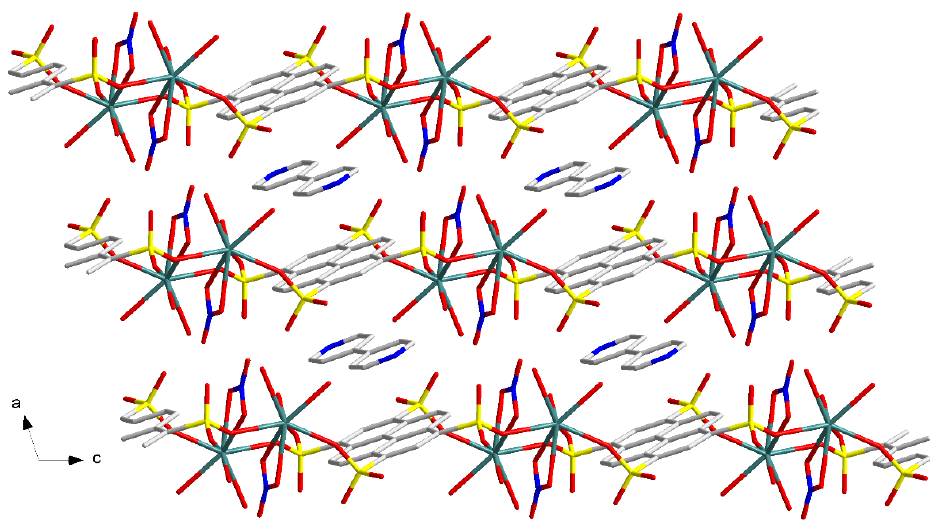
Figure 6. The packing structure in compound 2 .